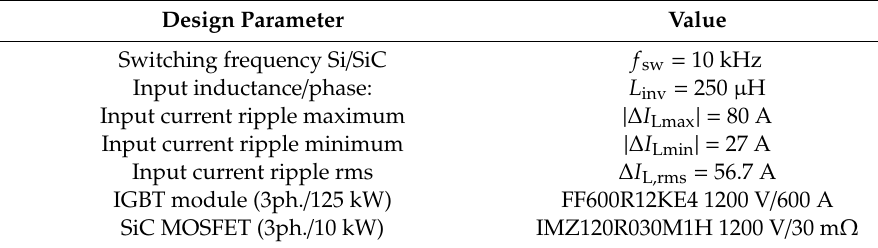
Table 2. System-level design specification of the three-phase converter (nominal